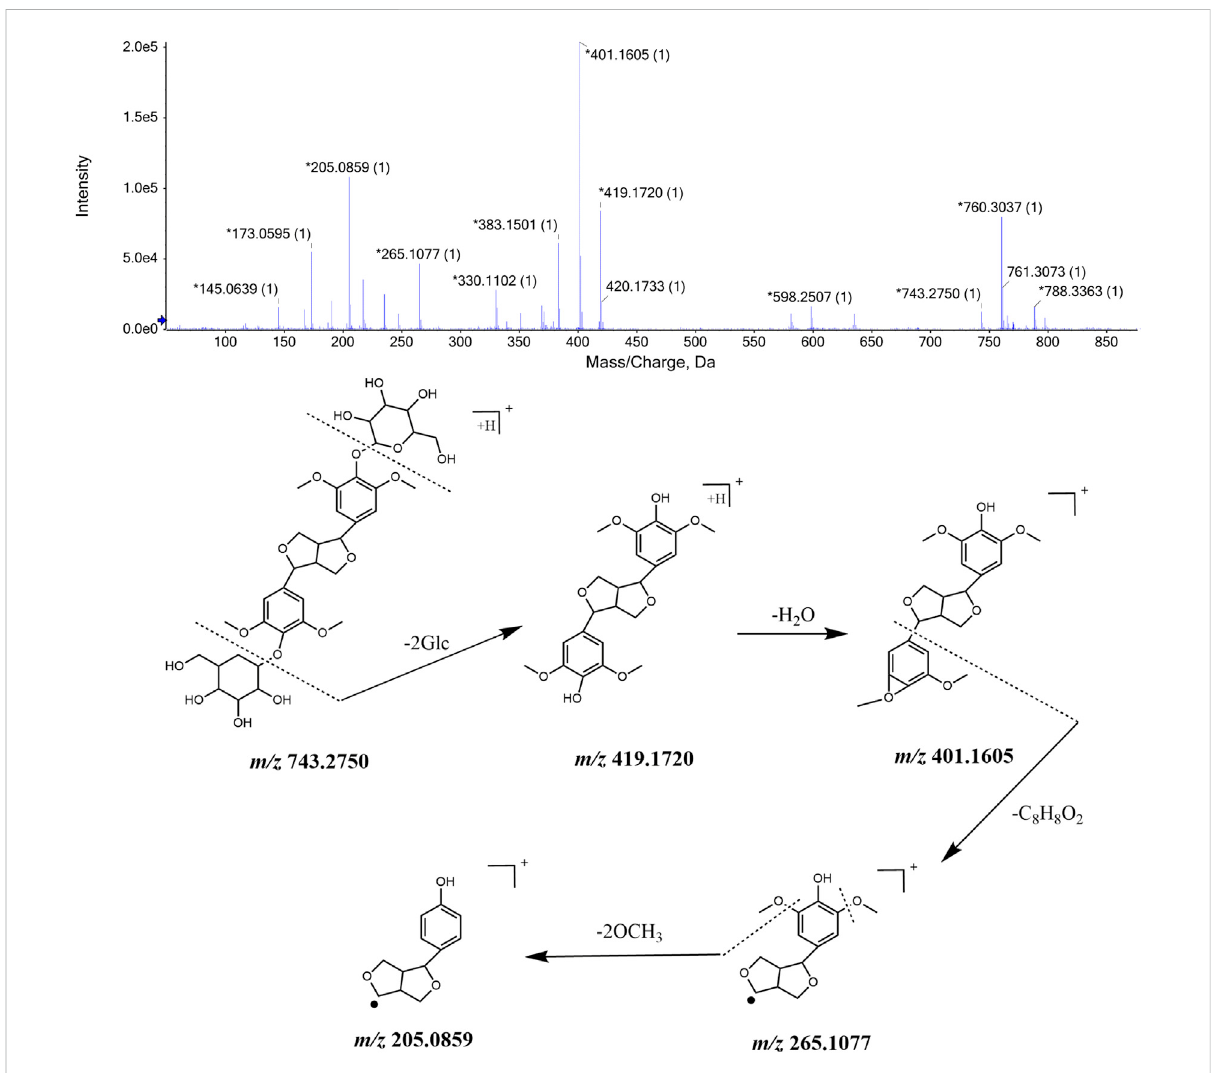
FIGURE 4 MS/MS spectrum of eleutheroside E in CWT and speculated fragmentation